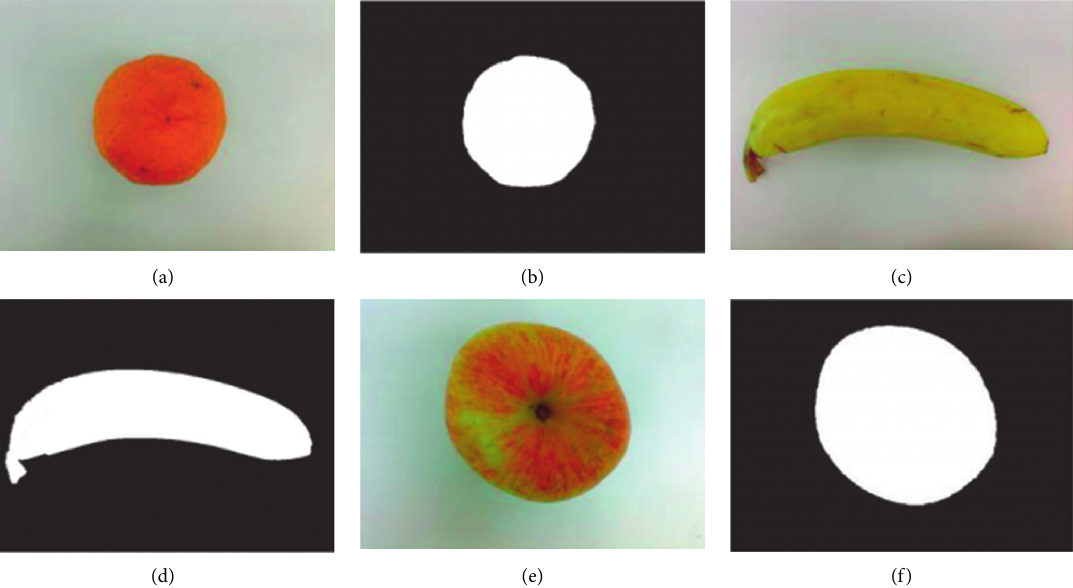
Figure 12: Colour images (food) are transformed into monochrome images. (a) Colour orange image. (b) Colour banana image. (c) Colour apple image. (d) Monochrome orange image. (e) Monochrome banana image. (f) Monochrome apple